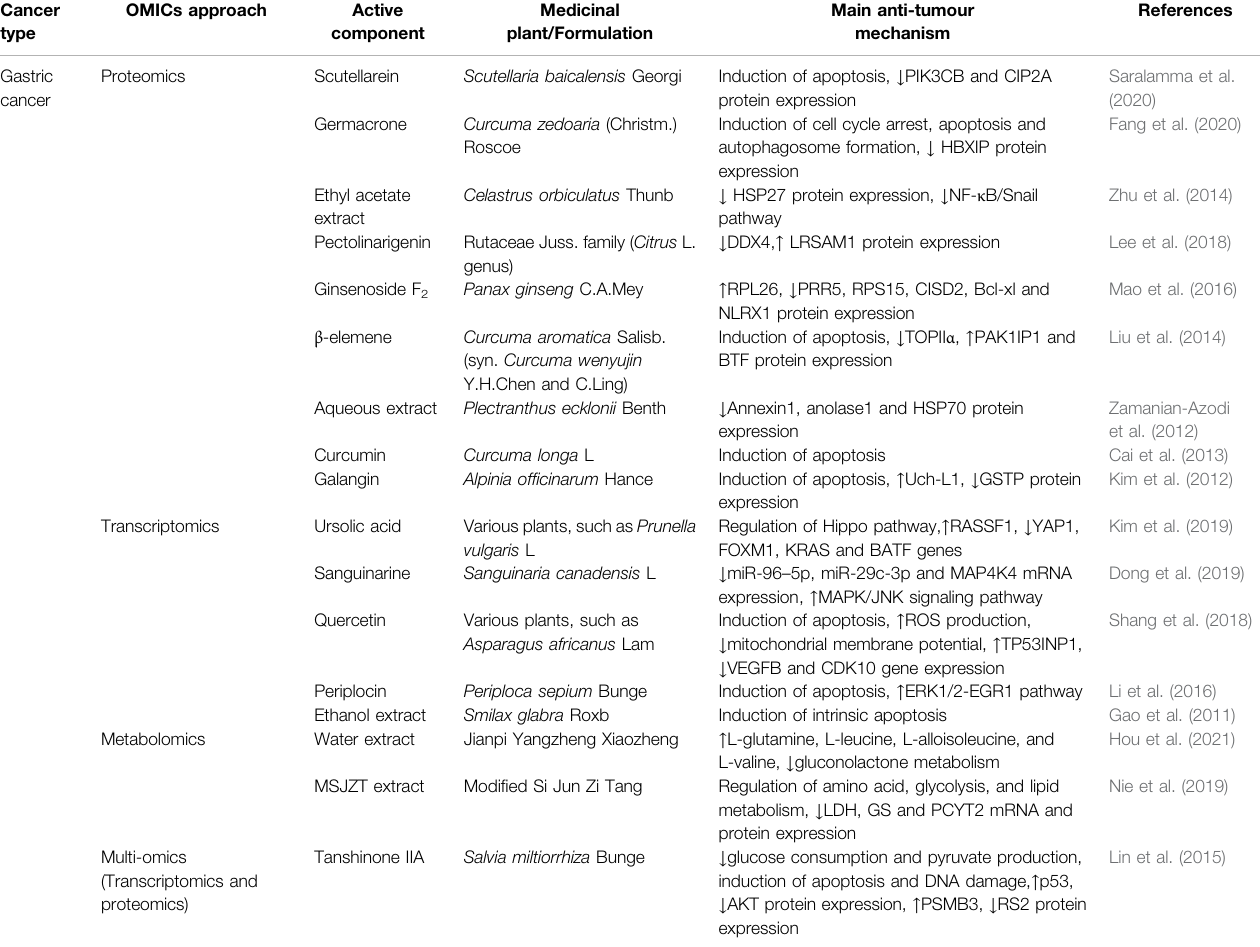
TABLE 2 | The applications of OMICS on medicinal plants in gastric